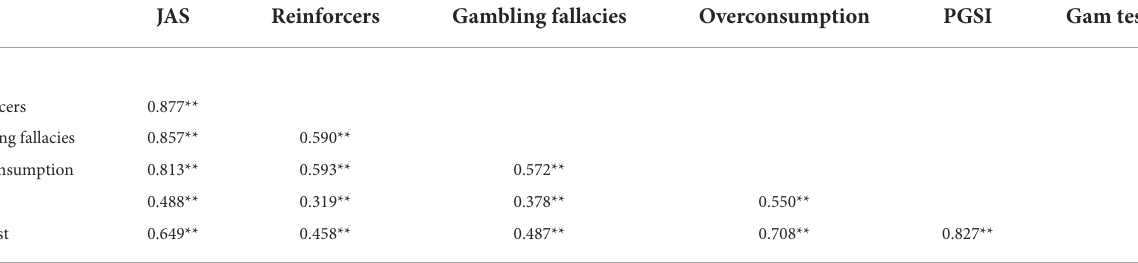
JAS Reinforcers Gambling fallacies